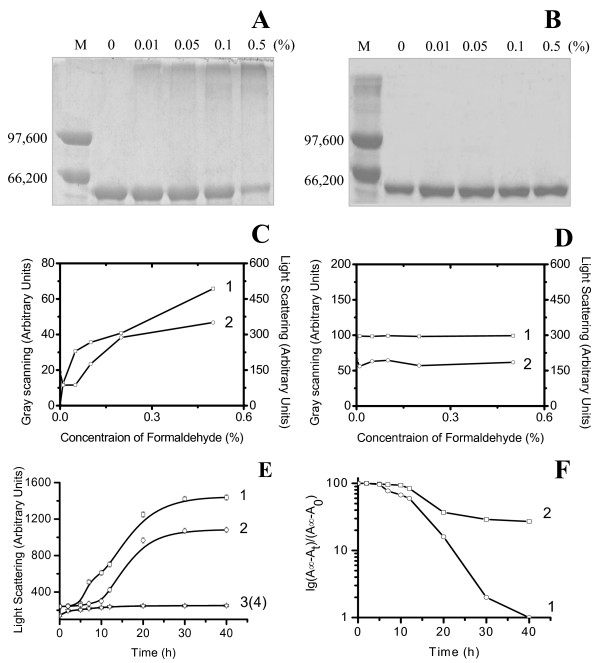
Effect of formaldehyde on tau aggregation at different concentrations. (A) Recombinant htau-40 (20 μM final concentration) was incubated with formaldehyde at desired concentrations in 100 mM phosphate buffer (pH 7.2) at 37°C for 24 h and aliquots (10 μl) were loaded for 10% SDS-PAGE. Lane M contains molecular mass standards. (B) BSA was used as a control. (C) Gray densities of tau polymers on SDS-PAGE were measured (curve 1) and changes in the light scattering of tau with formaldehyde at different concentrations were detected (curve 2). (D) The gray densities of BSA monomers from panel B (curve 1) and the light scattering of BSA (curve 2). (E) Tau-40 (1.2 μM final concentration) was incubated with 0.1 % formaldehyde and changes in the light scattering at 480 nm were measured at different time intervals in the presence (curve 1) or absence (curve 2) of formaldehyde. BSA alone (curve 3) or BSA incubated with formaldehyde (curve 4) was used as controls. (F) The same data as shown in panel E is plotted on a semi-logarithmic scale [36].